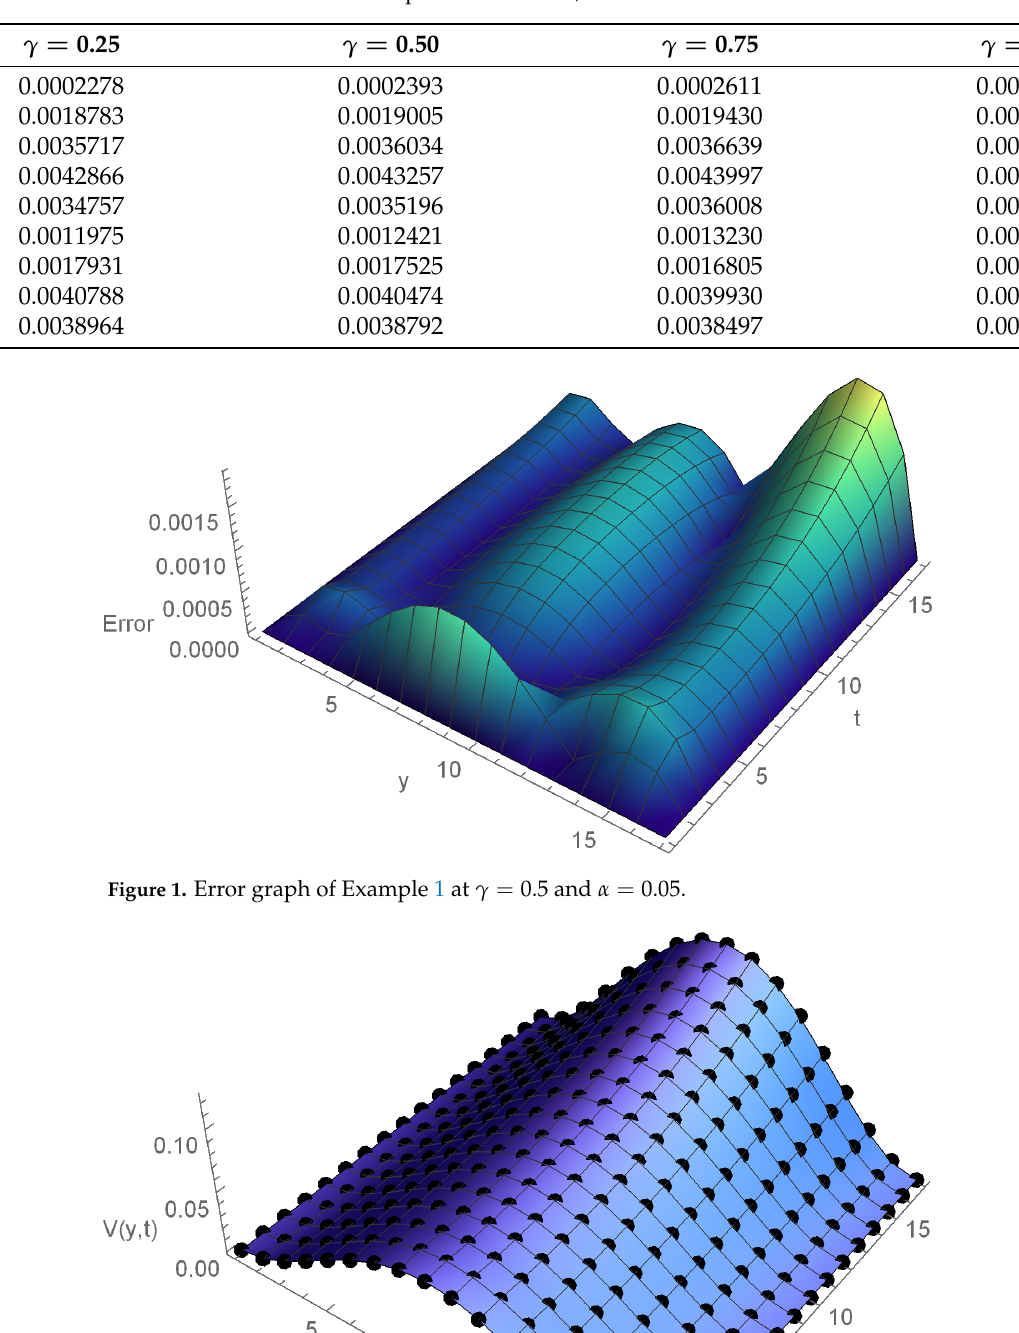
Table 3. Absolute errors Example 1 for α = 0.15, at various knots.